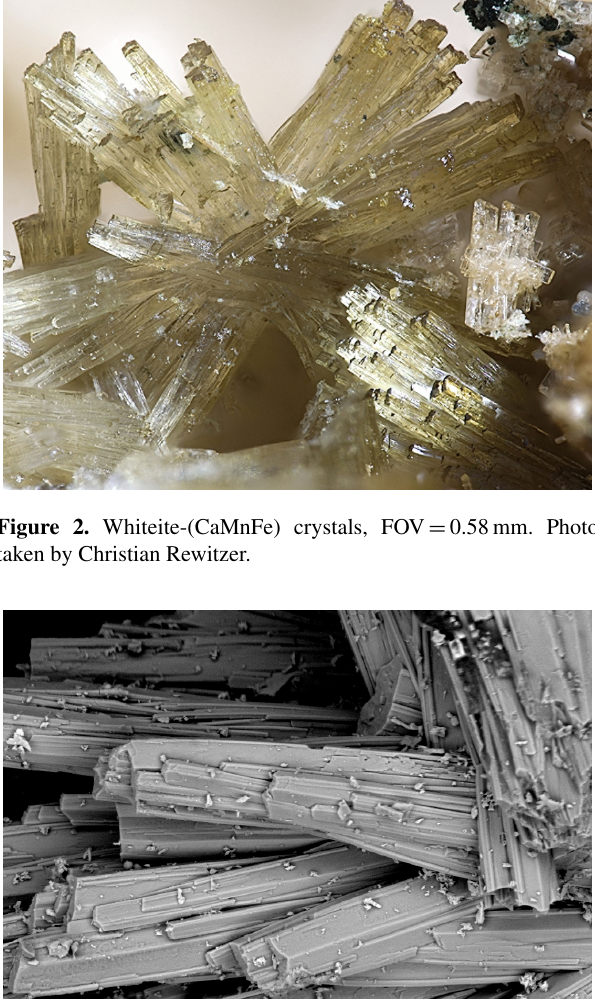
Optically, whiteite-(CaMnFe) crystals are biaxial ( + ), with α = 1 . 608 ( 3 ) , β = 1 . 612 ( 3 ) and γ = 1 . 624 ( 3 ) (mea- sured in white light). The measured 2 V from extinction data analysed with EXCALIBR (Gunter et al., 2004) is 59(1) ◦ , and the calculated 2 V is 60.4 ◦ . Dispersion and pleochro- ism were not observed. The partially determined optical ori- entation is Y = b . The Gladstone–Dale compatibility index (Mandarino, 1981) is 0.007 (superior) based on the empiri- cal formula and the measured density.